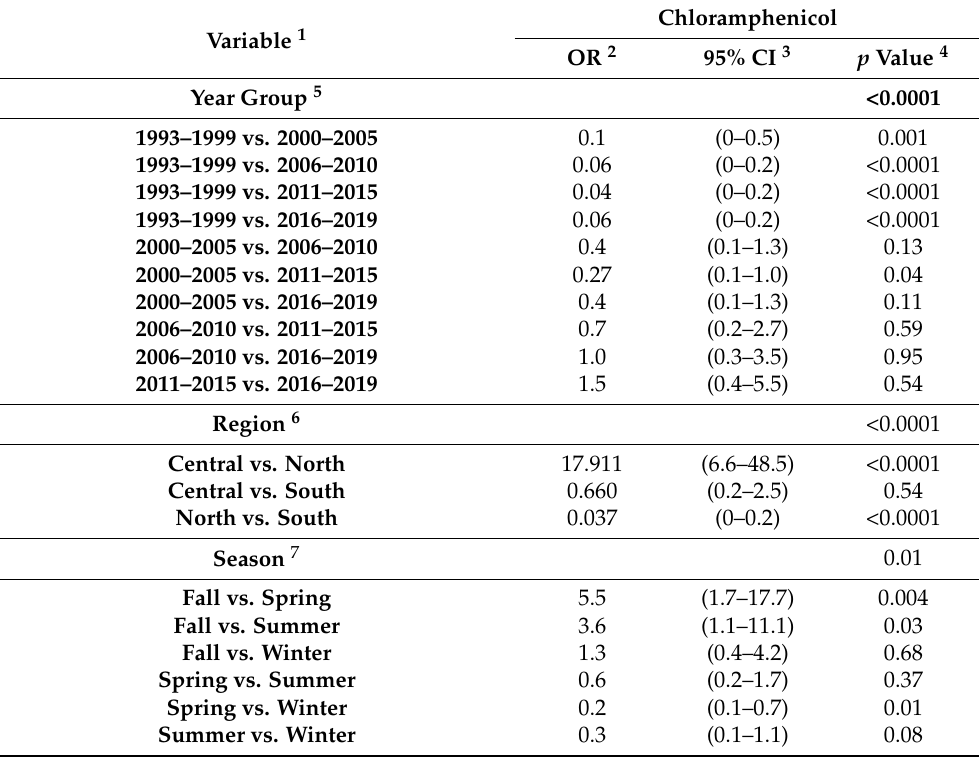
Table 8. Odds ratio for the effect of year group and region for a S. Dublin classified as resistant for chloramphenicol in the NARMS panel. p values in bold indicate significant odds ratio associations.